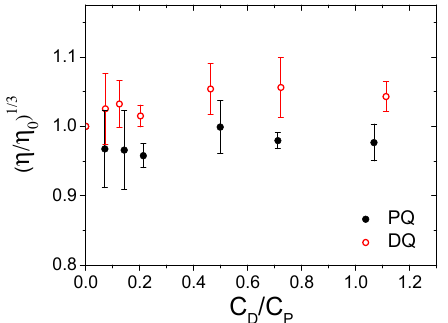
Figure 4. Relative viscosity vs. herbicide/DNA ratio (C D /C P ) for PQ (full mark) and DQ (open mark); C DNA = 1.77 × 10 − 4 M, C PQ from 0 to 1.92 × 10 − 4 M, C DQ from 0 to 2.0 × 10 − 4 M, NaCl 0.1 M, NaCac 2.5 mM, pH 7.0, 25.0 °C.